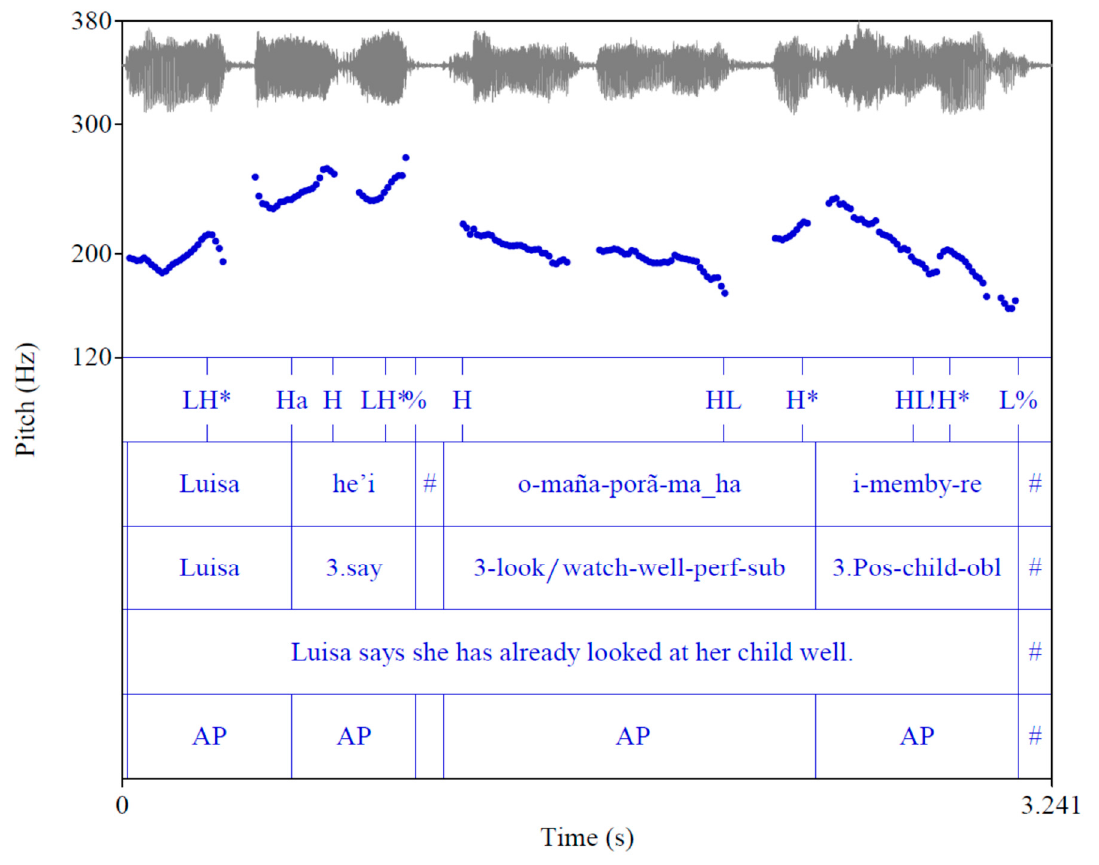
Figure 2. Luisa he’i omañaporãmaha imembýre.